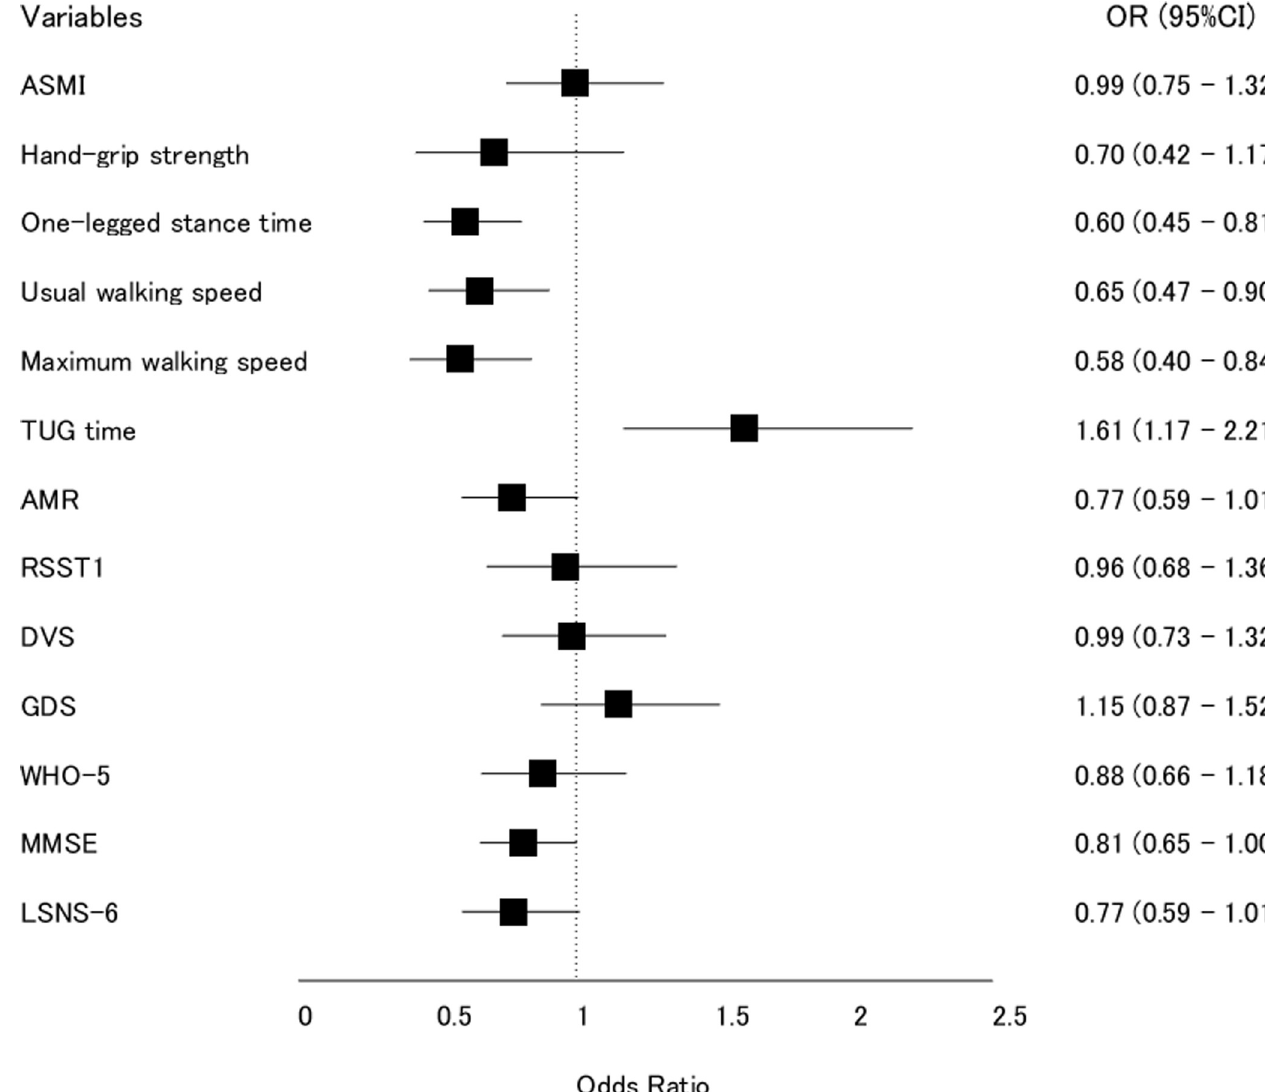
Fig 2. Odds ratios (ORs) and 95% confidence intervals for the association of each variable at the baseline survey with IADL decline after two years. All the ORs were adjusted for baseline age, gender, weight, height, and medical history. Abbreviations: ASMI, appendicular skeletal mass index; TUG = timed up & go; AMR = alternating motion rate; RSST = repetitive saliva swallowing test; DVS = dietary variety score; GDS = Geriatric Depression Scale, WHO-5 = World Health Organization-Five Well-being Index; MMSE = Mini-Mental State Examination; LSNS-6 = Lubben Social Network Scale.